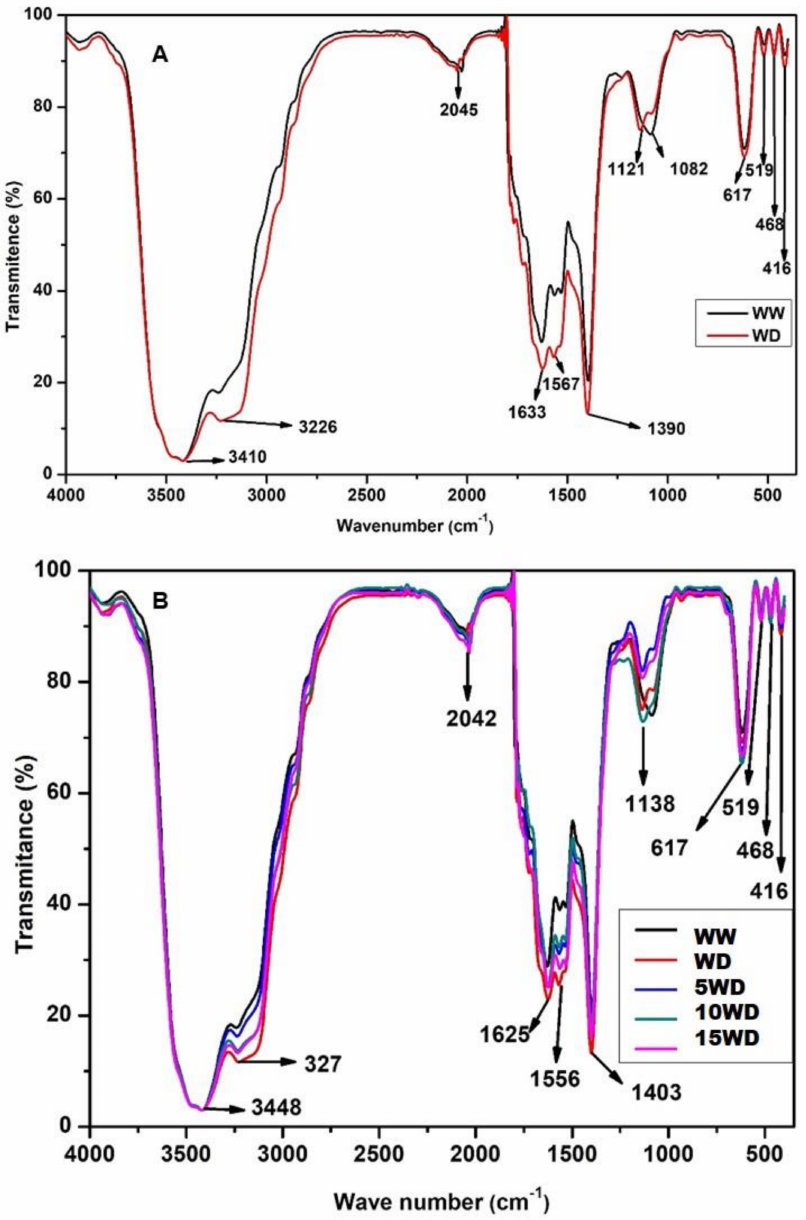
Figure 7. FTIR analysis of the effect of drought ( A ) and α Fe 2 O 3 NP priming ( B ) on biomolecules in sorghum plants. WW (well-watered) = control plants (black), WD (water-deprived) = drought stress (red), 5WD = drought-stressed plants primed with 5 mg/L α Fe 2 O 3 NPs (blue), 10WD = 10 mg/L α Fe α Fe 2 O 3 NPs (green) and 15WD = 15 mg/L 2 O 3 NPs